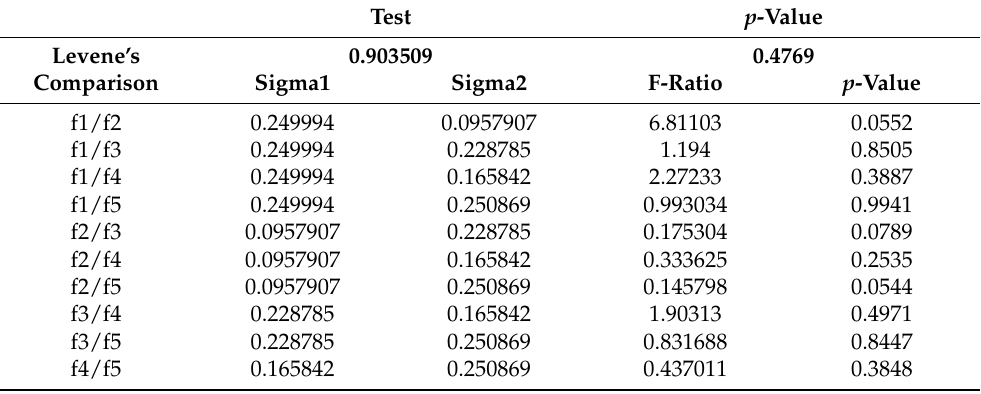
Table 10. Variance